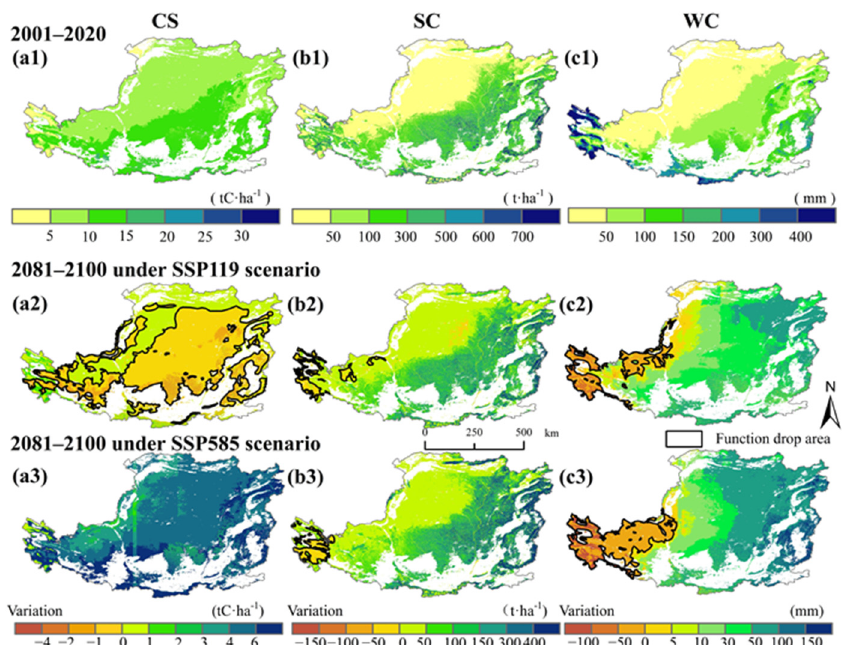
Figure 5. Spatiotemporal distribution during 2001–2020 and changes during 2081–2100 relative to 2001–2020 in the CS, SC, and WC of the Loess Plateau. Note: carbon stock function, CS; soil conservation function, SC; water conservation function, WC. ( a1 ): the spatiotemporal distribution of the CS during 2001–2020; ( a2 , a3 ): the changes of the CS during 2081–2100 relative to 2001–2020 under SSP119 and SSP585 scenarios; ( b1 ): the spatiotemporal distribution of the SC during 2001–2020; ( b2 , b3 ): the changes of the SC during 2081–2100 relative to 2001–2020 under SSP119 and SSP585